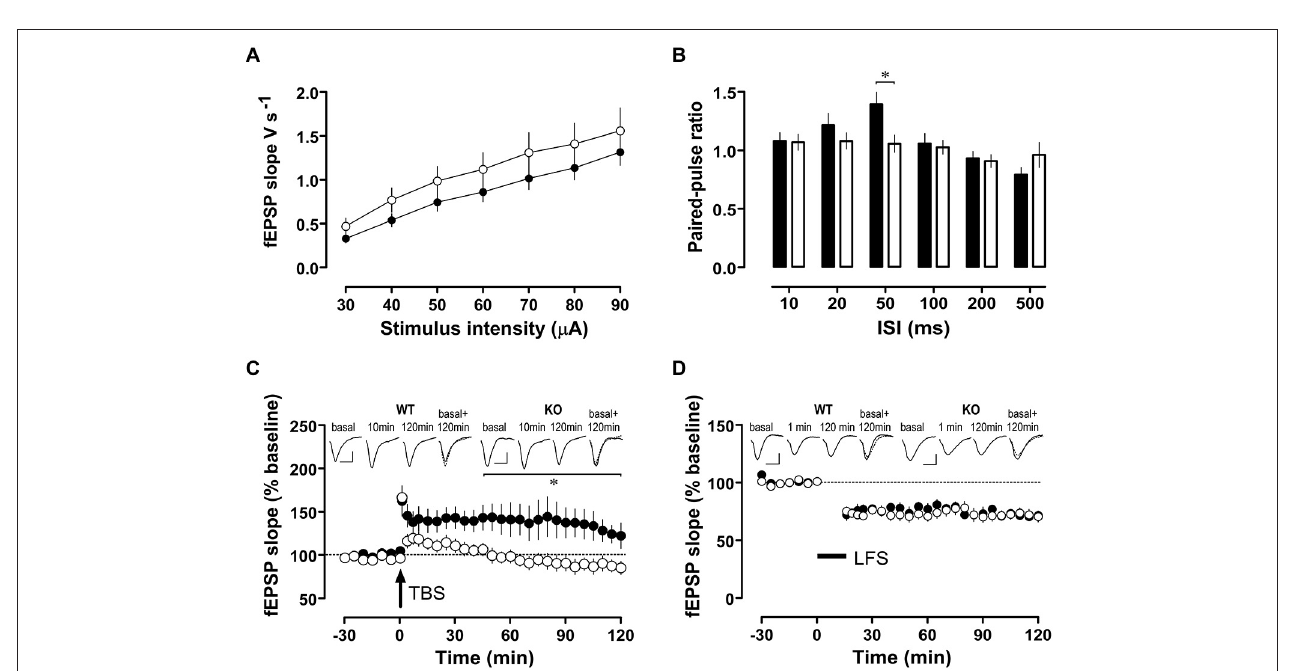
FIGURE 5 | Animals were trained under increasing reinforcement schedules to obtain food pellets through nose poking (A). Reinforced schedules included fixed ratio (FR), variable ratio (VR) and variable interval (VI). Superimposed fear conditioning